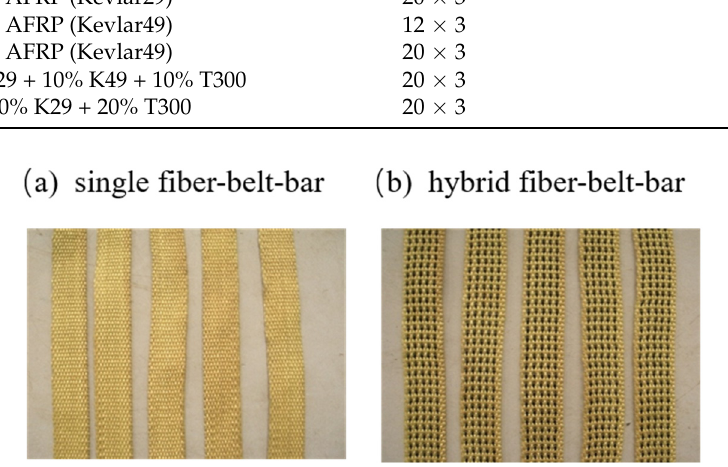
Figure 1. The photos of fiber-belt-bars.